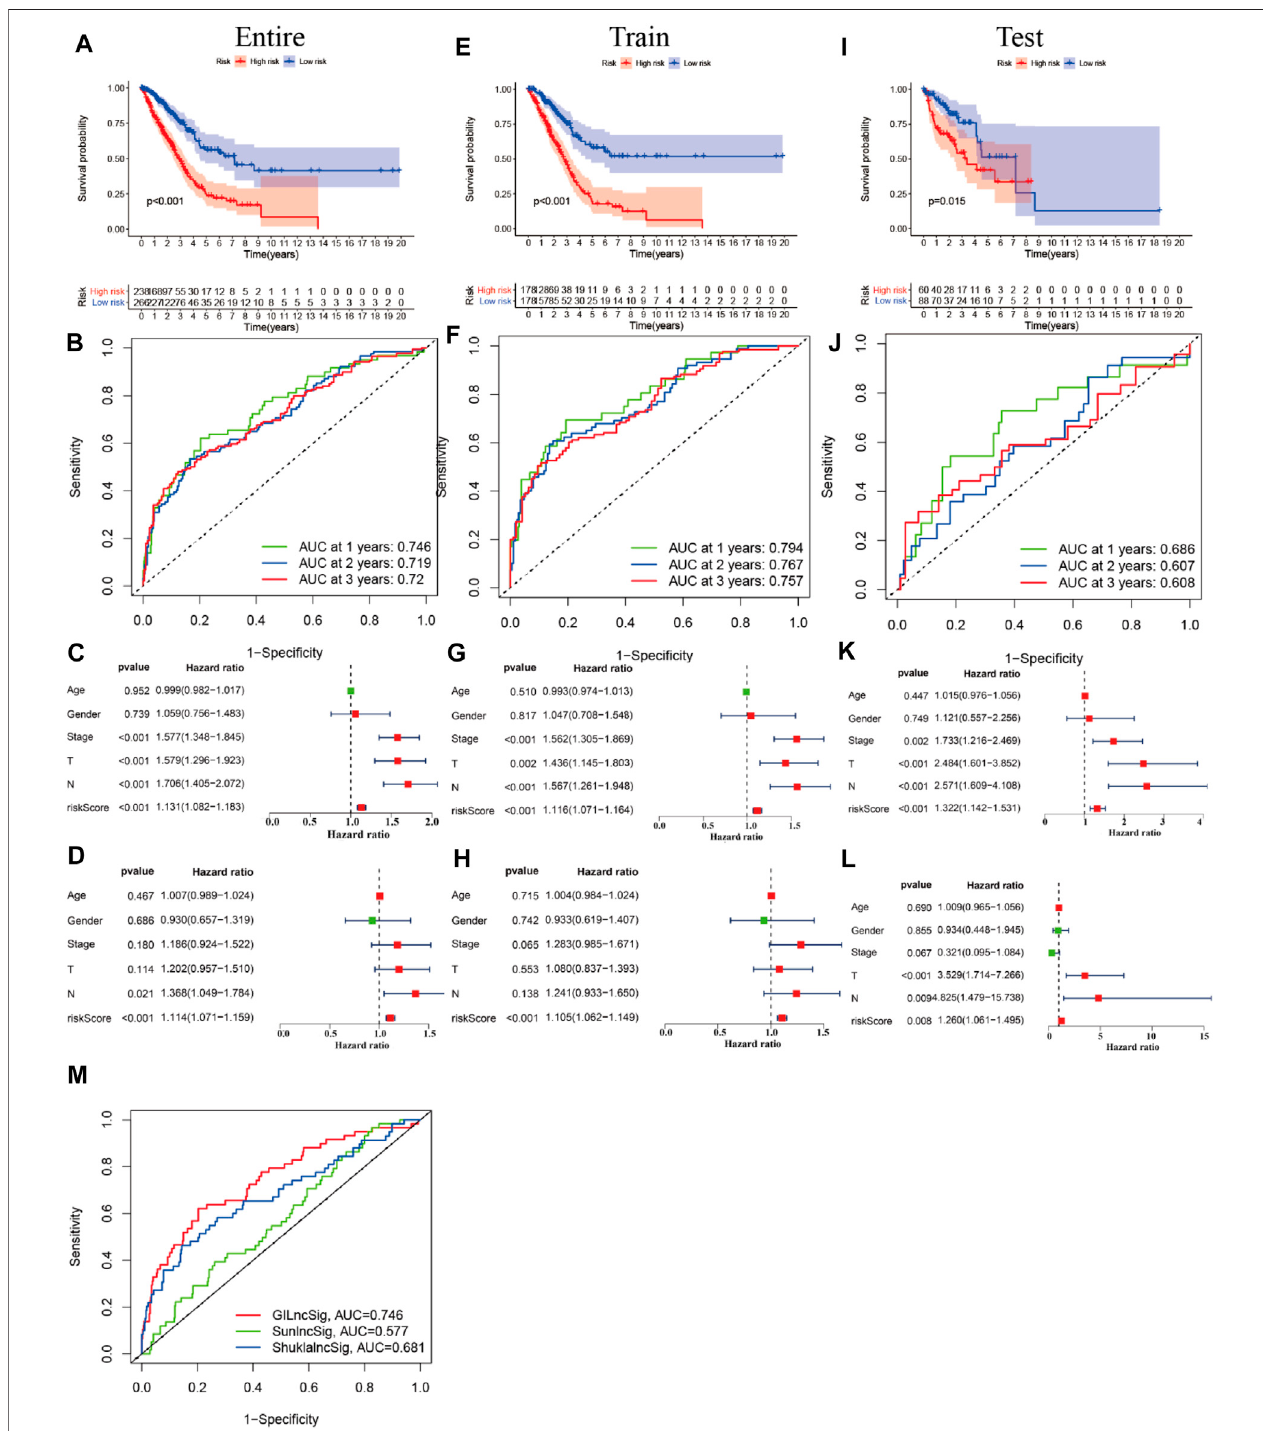
FIGURE 8 | Prognostic value of m 6 A-related lncRNAs of entire, training, and testing cohorts of LUAD patients. (A,E,I) Survival analysis of the prognostic model of the entire, training, and testing cohorts of LUAD patients. (B,F,J) ROC AUC at 1, 2, and 3 years in the entire, training, and testing cohorts. (C,G,K) Forest map of univariateCoxindependentregressionanalysesoftheprognosticmodelfortheentire,training,and testingcohorts. (D,H,L) ForestmapofmultivariateCoxindependent regression analyses of the prognostic model for the entire, training, and testing cohorts. (M) ROC curve of AUC analysis for our prediction model and other published prognostic